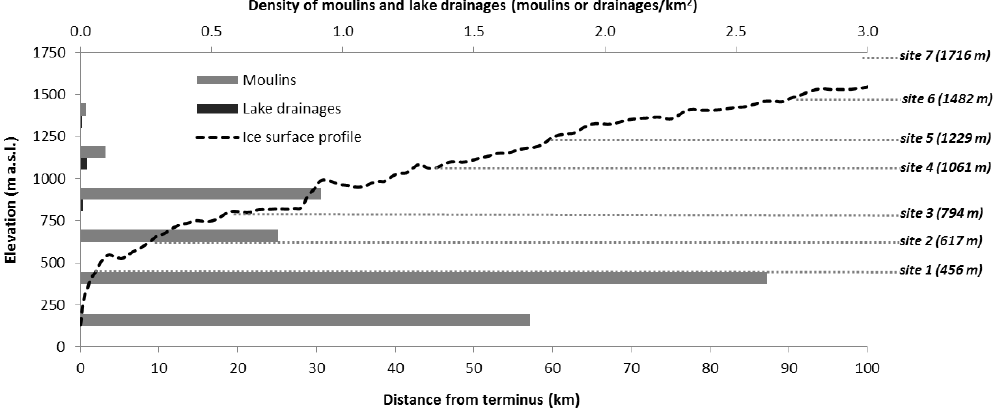
Figure 5. Density of moulins and lake drainages for 2009 within 250m ice surface elevation bands. Sites of GPS velocity measurements (Fig. 1; Bartholomew et al., 2011b) are shown against the Leverett catchment ice surface profile. Note that only a very small area of the derived Leverett catchment lies below 500m elevation, where outlet glaciers emerge at the margin of the ice sheet.